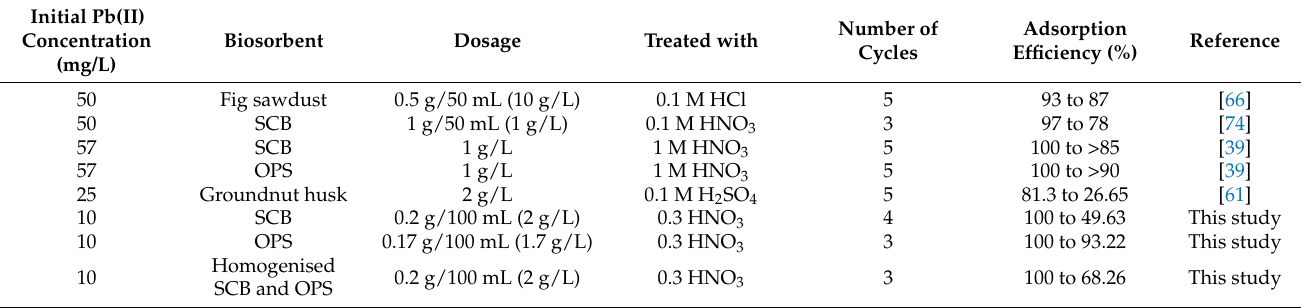
Table 5. Comparison of removal efficiencies of Pb(II) using several regenerated cellulose-based agricultural adsorbents.